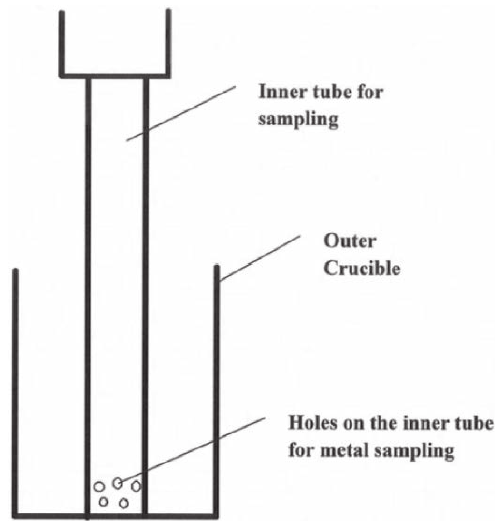
Fig. 6: Crucible design for experiment [21].